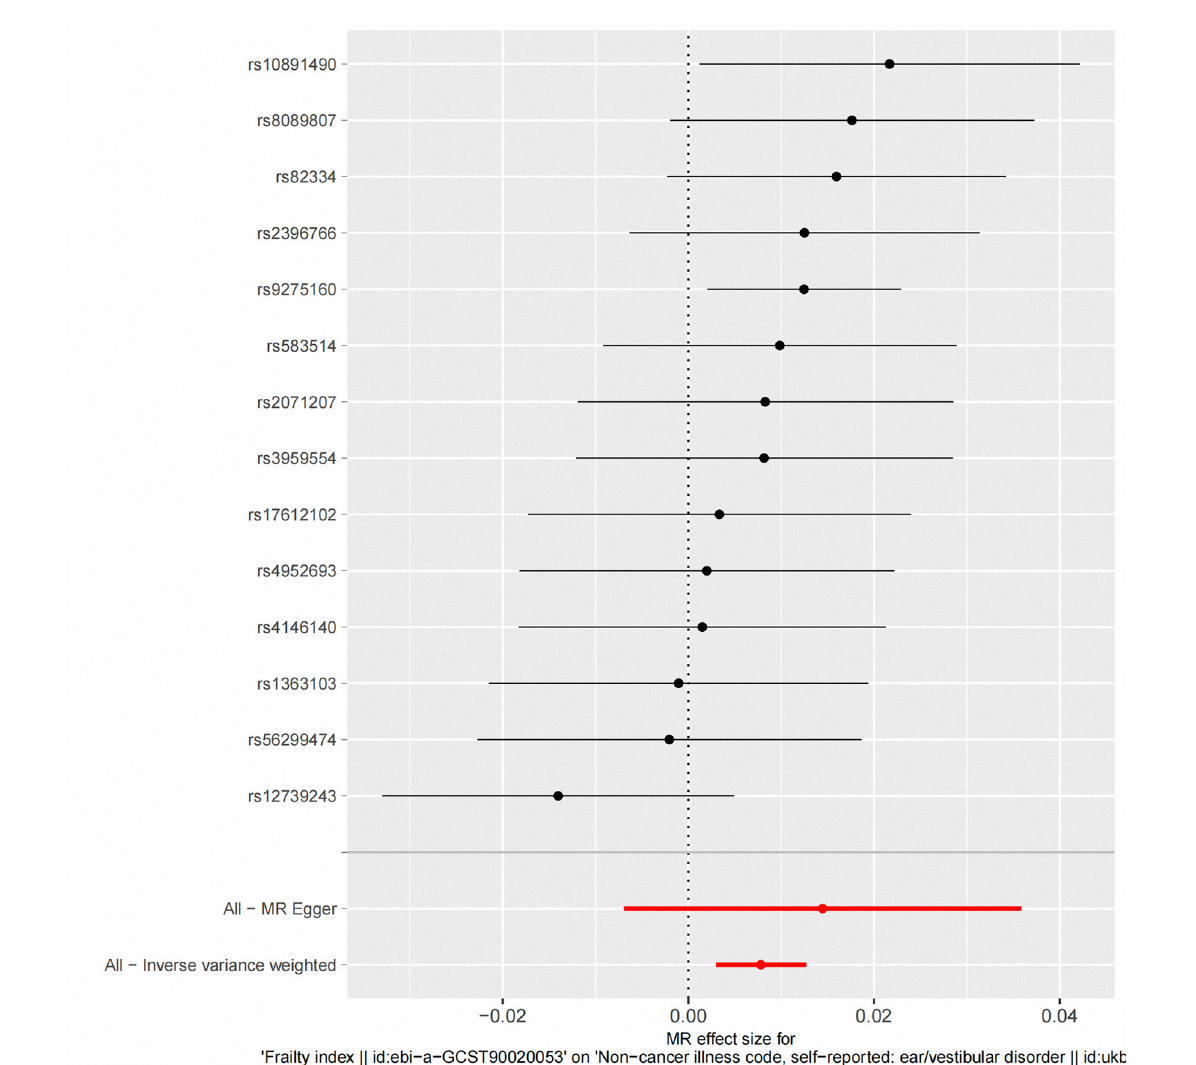
FIGURE3 Fixed-effect IVW analysis of the causal association between frailty index and vestibular disorders. The black dots and bars indicate the causal estimate and 95% CI using each SNP. The red dot and bar indicate the overall estimate and 95% CI meta-analyzed by fixed-effect IVW method. IVW, inverse-variance weighted; HI, hearing impairment; CI, confidence interval; SNP, single nucleotide